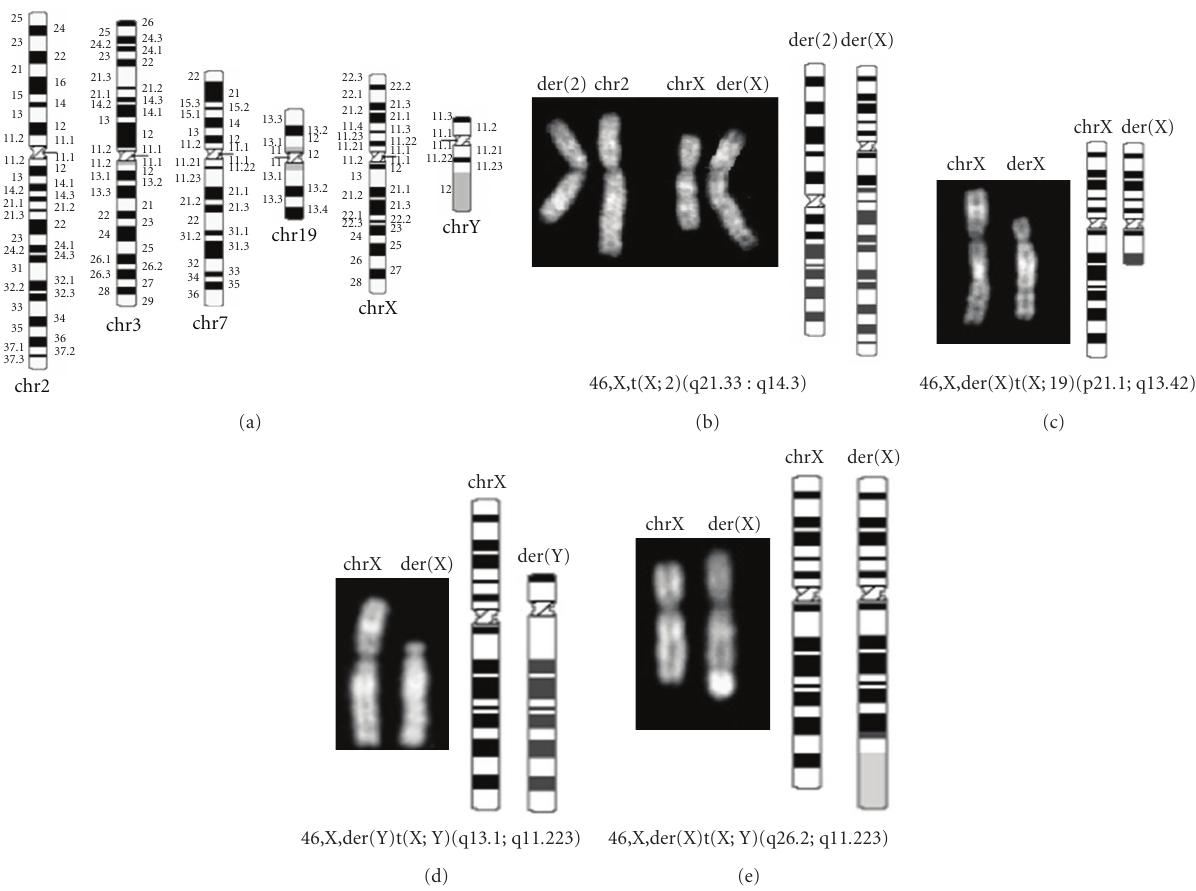
Table 3: FISH analysis on interphase nuclei data and statistical analysis.